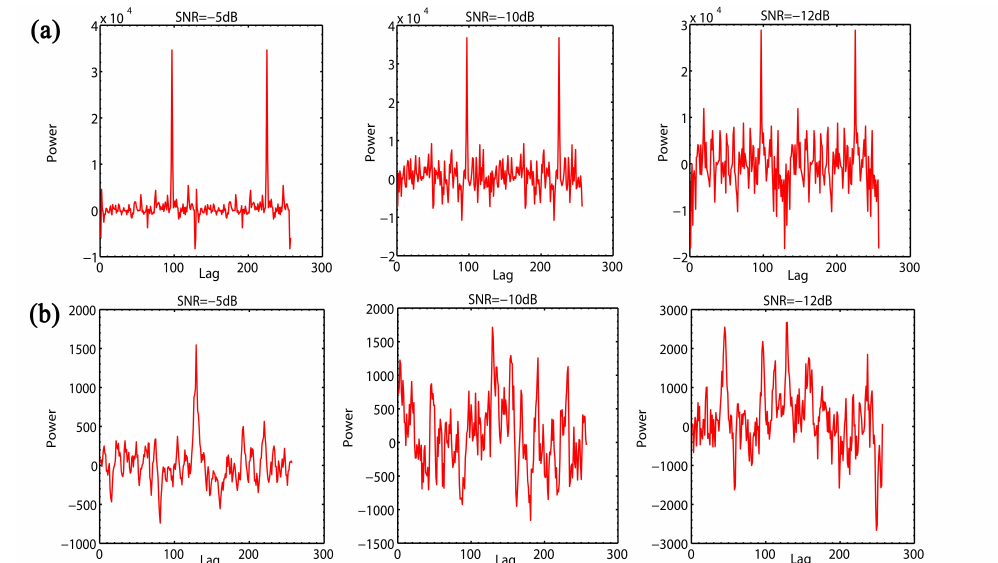
Figure 9. ( a ) Range ambiguity function of the composite codes of the 4-bit strong alternatig code modulated by 16-bit complementary code with SNR of − 5 dB, − 10 dB and − 12 dB and ( b ) Range ambiguity function of the 16-bit alternating code with SNR of − 5 dB, − 10 dB and − 12